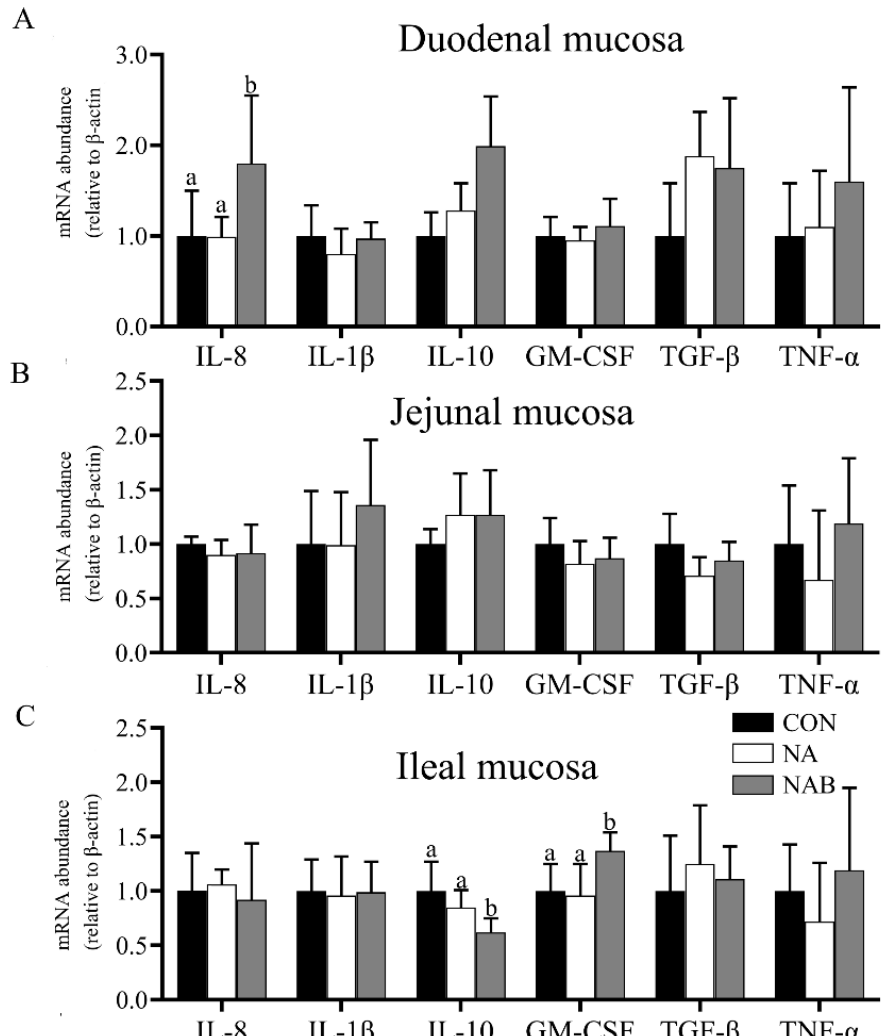
Figure 3. Effect of niacin on the mRNA expression genes related to the inflammatory response in the small intestinal mucosa of weaned piglets; ( A ) Duodenal mucosa; ( B ) Jejunal mucosa; ( C ) Ileal mucosa. Values are expressed as the mean ± SD, n = 8/treatment. IL-8, interleukin-8; IL-1 β , interleukin-1 β ; IL-10, interleukin-10; GM-CSF, granulocyte-macrophage colony stimulating factor; TGF- β , transforming growth factor- β ; TNF- α , tumor necrosis factor- α . a, b Values with different superscripts in the same row differ significantly ( p < 0.05). CON, control group; NA, niacin group; MPN, GPR109A antagonist group.